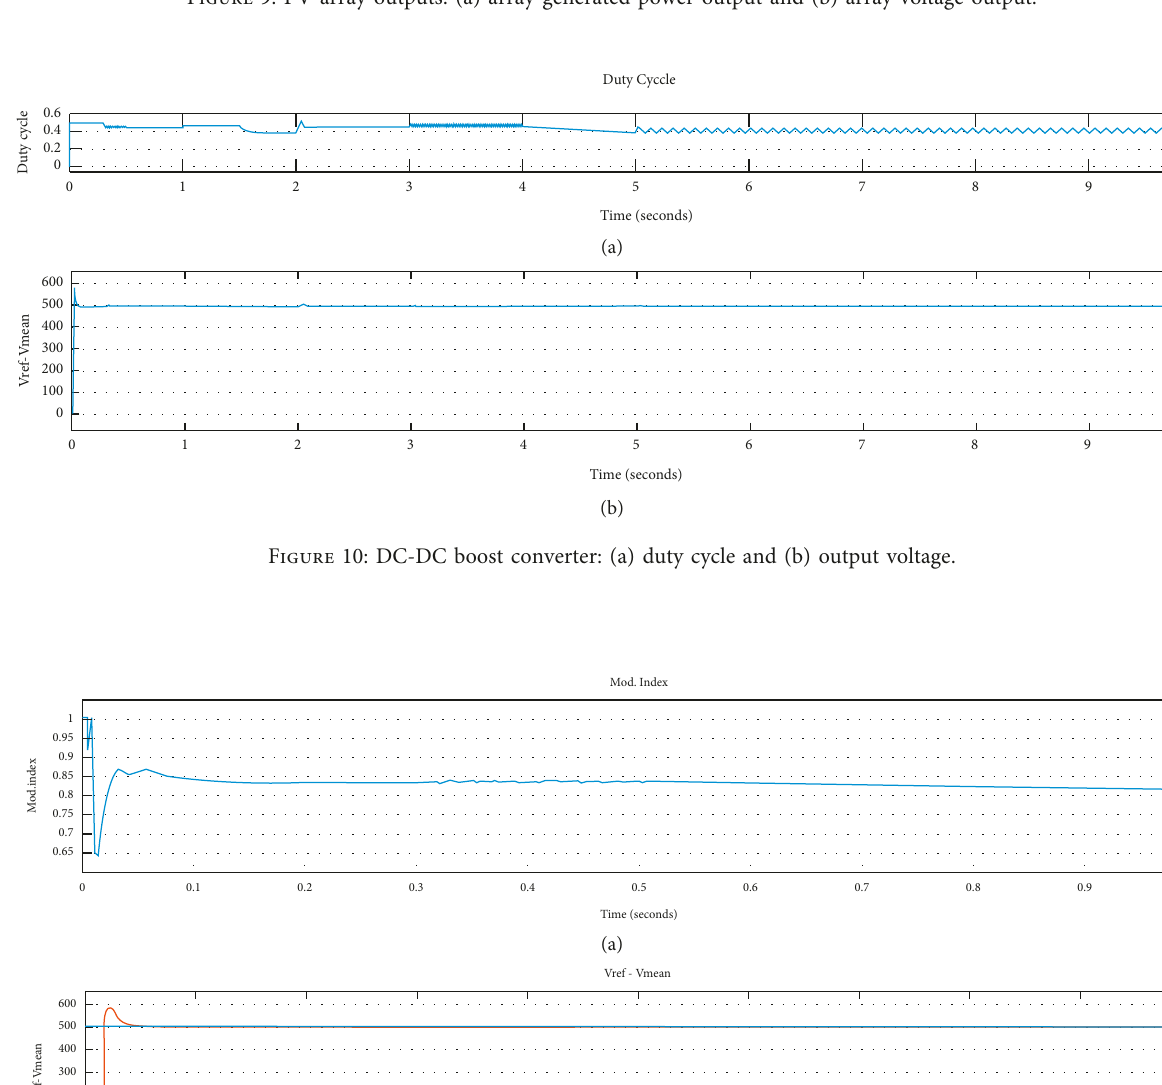
Figure 9: PV array outputs: (a) array generated power output and (b) array voltage output.